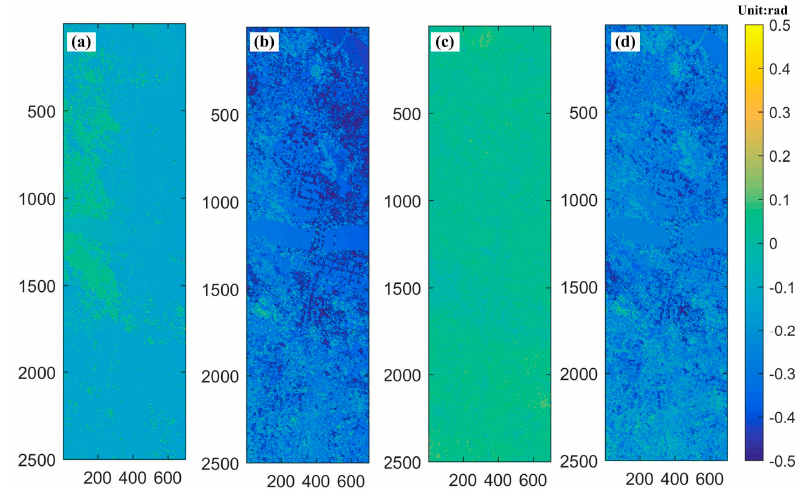
Figure 11. Mean Residual Phases of different models: ( a ) MVM; ( b ) PVM; ( c ) SM; ( d ) CPM.